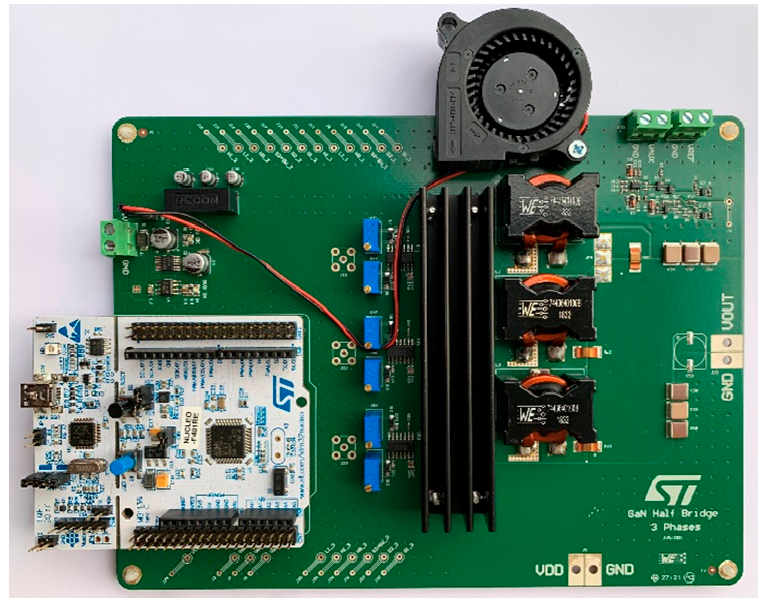
Figure 9. Evaluation board of the converter.